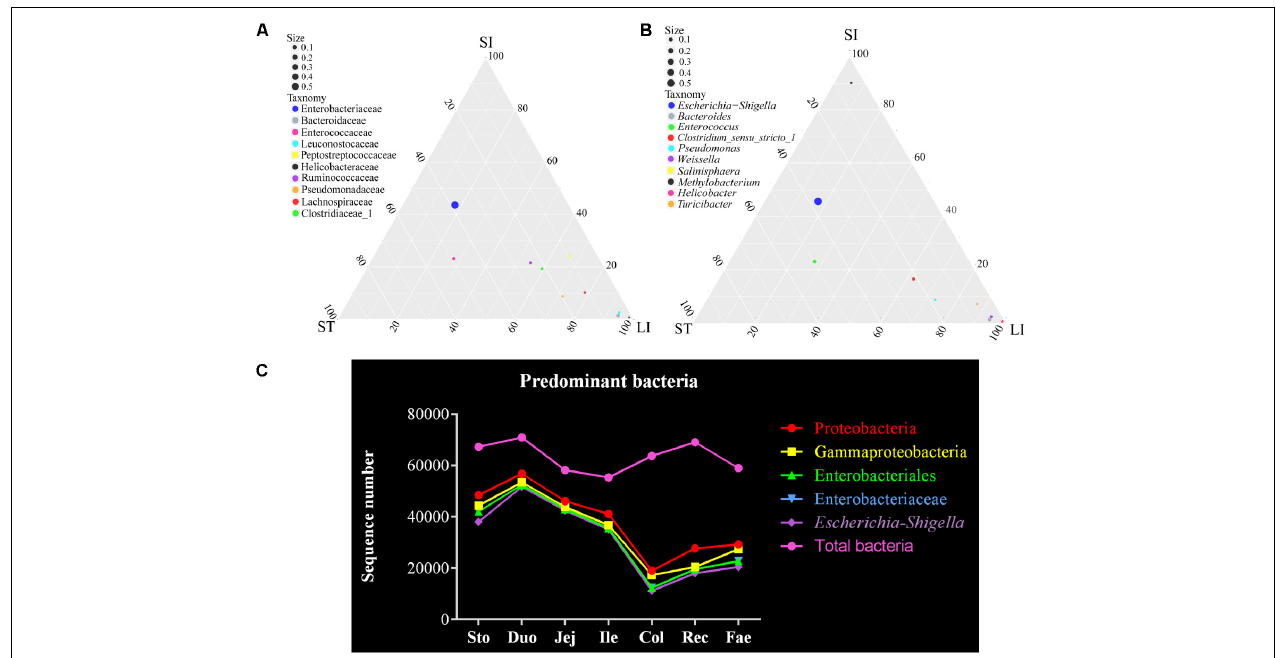
FIGURE 4 | Escherichia–Shigella is a major genus of bacteria in the red panda GIT. (A) The ternary plot of bacterial between the stomach, small intestine, and large intestine at family level. The three vertices in the figure represent the sample group (ST: stomach; SI: small intestinal; LI: large intestinal). Circles represent species, and size represents relative abundance. The closer the circle is to the vertex, the higher the relative abundance of this species. (B) The ternary plot of bacterial between the stomach, small intestine, and large intestine at genus level. (C) Total bacteria and the major bacterial genera of Escherichia–Shigella , classified from the phylum to genus level across the